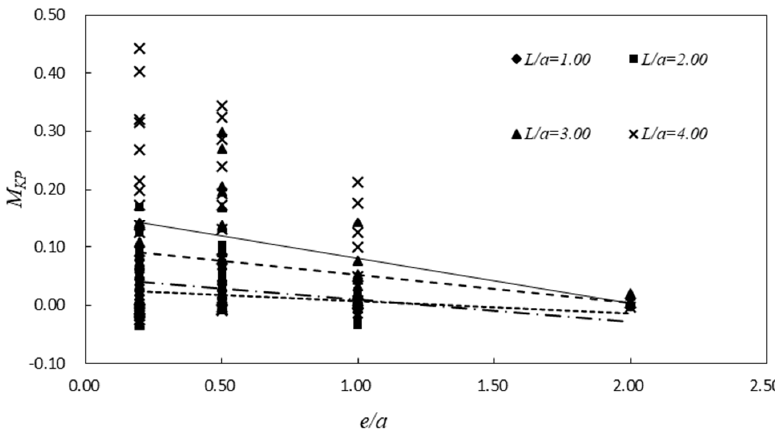
Figure 6. M KP vs. various e/a ratios for L/a = 1.00, 2.00, 3.00 and 4.00.